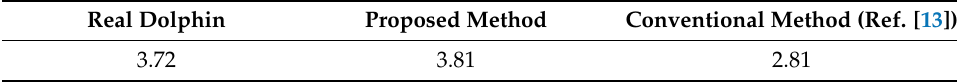
Table 6. Average MOS result for the 2nd assessment.